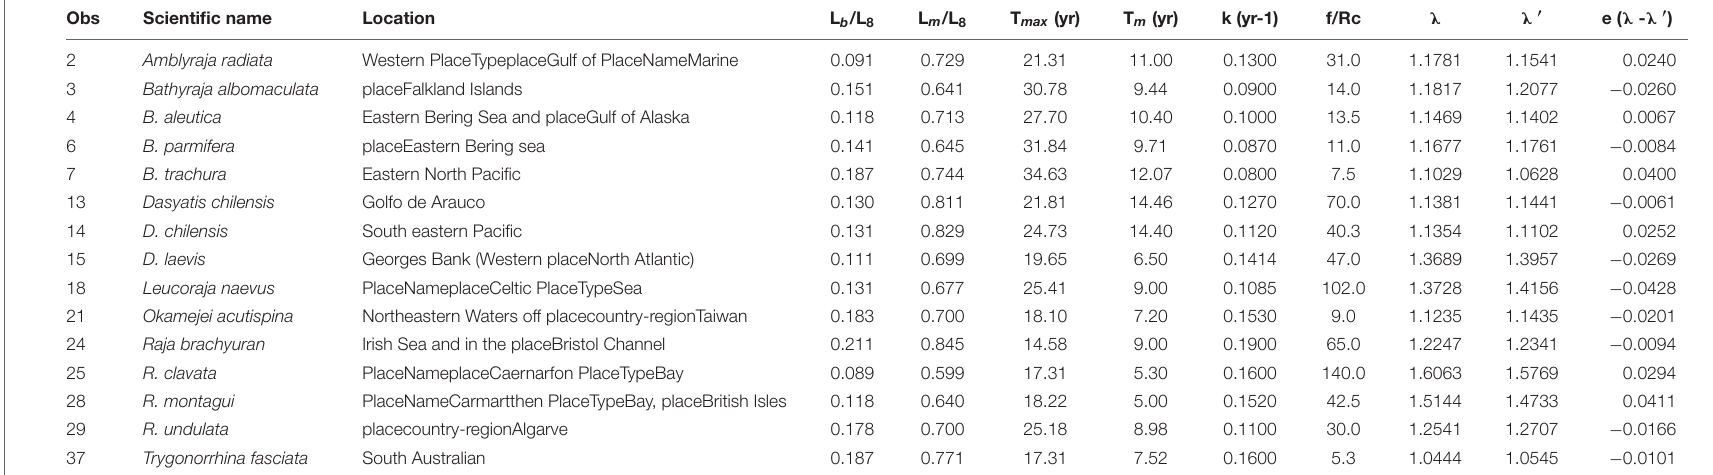
TABLE 3B | Life history parameters and estimated finite rate of population increase for the stocks of skates and rays in group 2. Obs